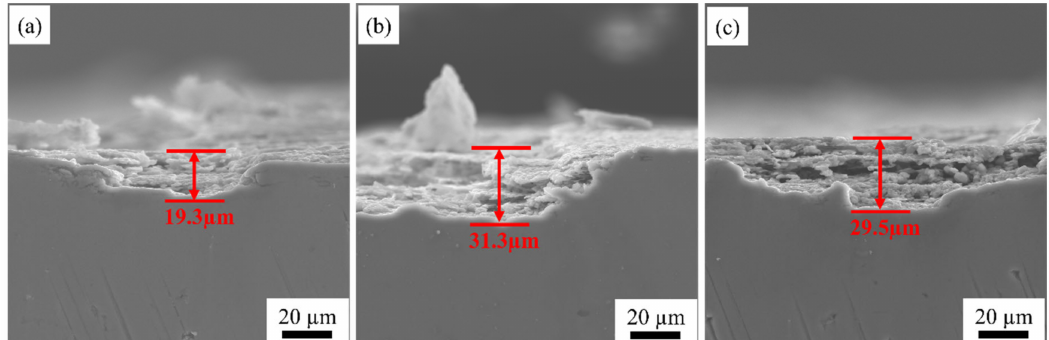
Figure 14. SEM image of corrosion morphology of samples at different rolling temperatures after aging treatment: S420 ( a ), S450 ( b ), S480 ( c